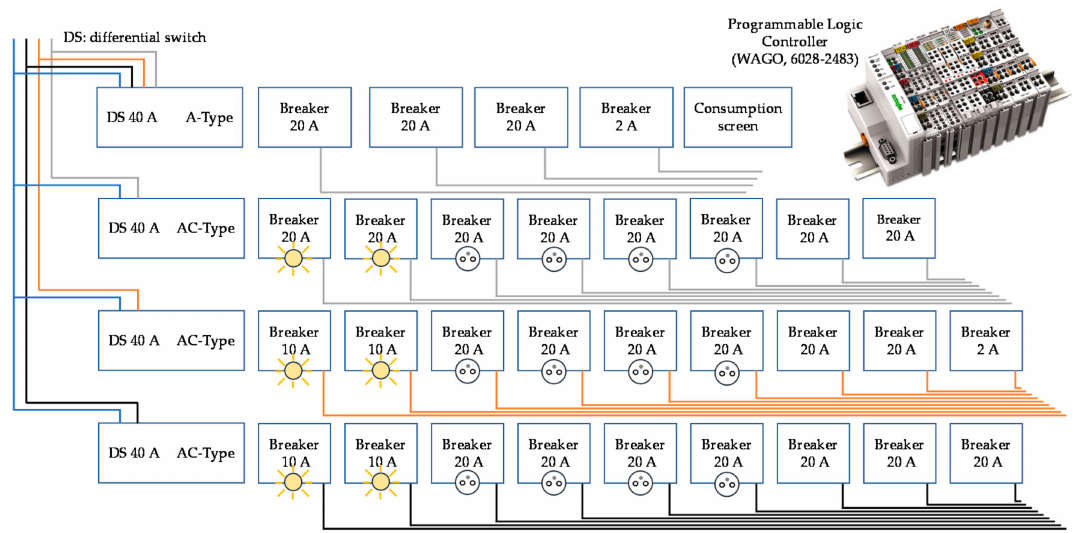
Figure 2. Example of wiring of the measurement system in the electric panel of a smart home.